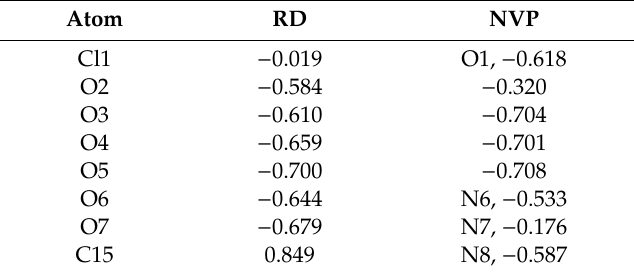
Table 1. Natural atomic charge (in esu) distribution on some selected atoms within the optimized inhibitors at SMD / B3LYP / 6-311G(d,p) level of